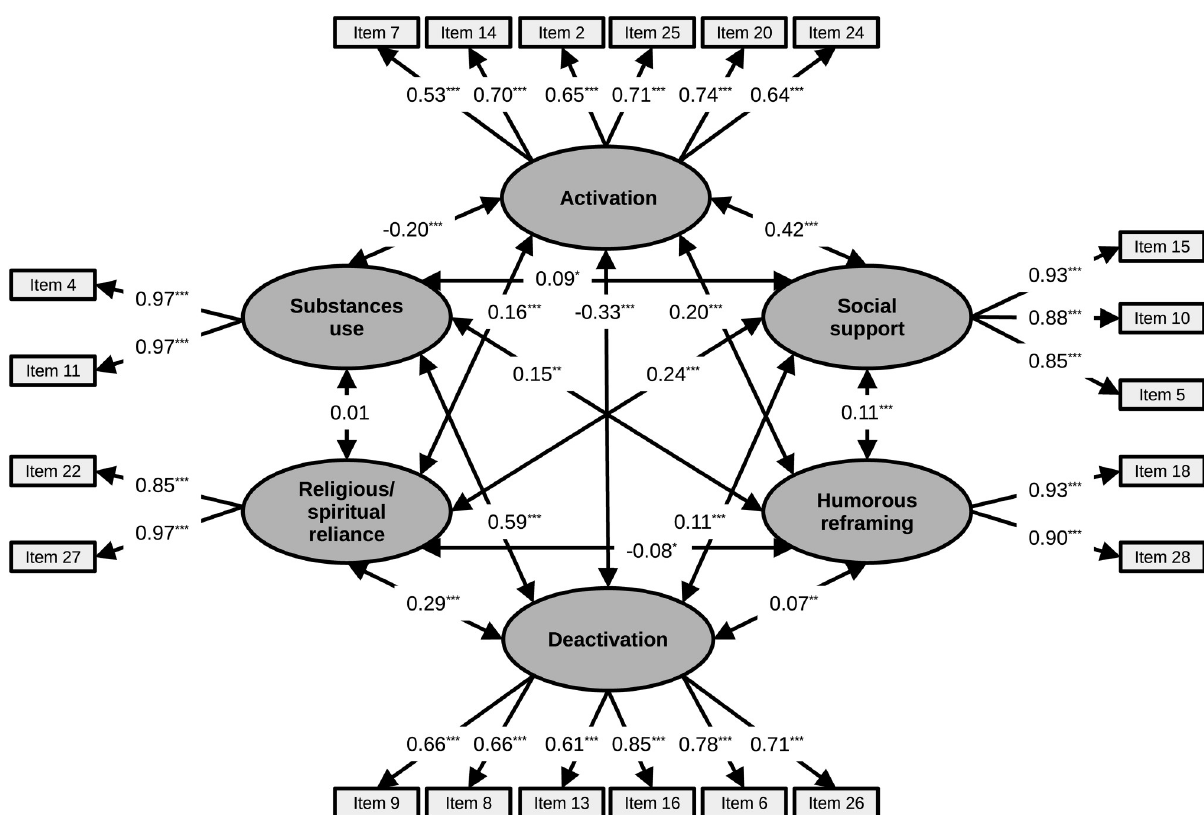
Fig 1. Factorial model of the I-Brief Cope scale. The digits represent standardized factor loadings. � p < 0.05; �� p < 0.01; and ��� p < 0.001. A two-way arrow between two variables indicates correlation.